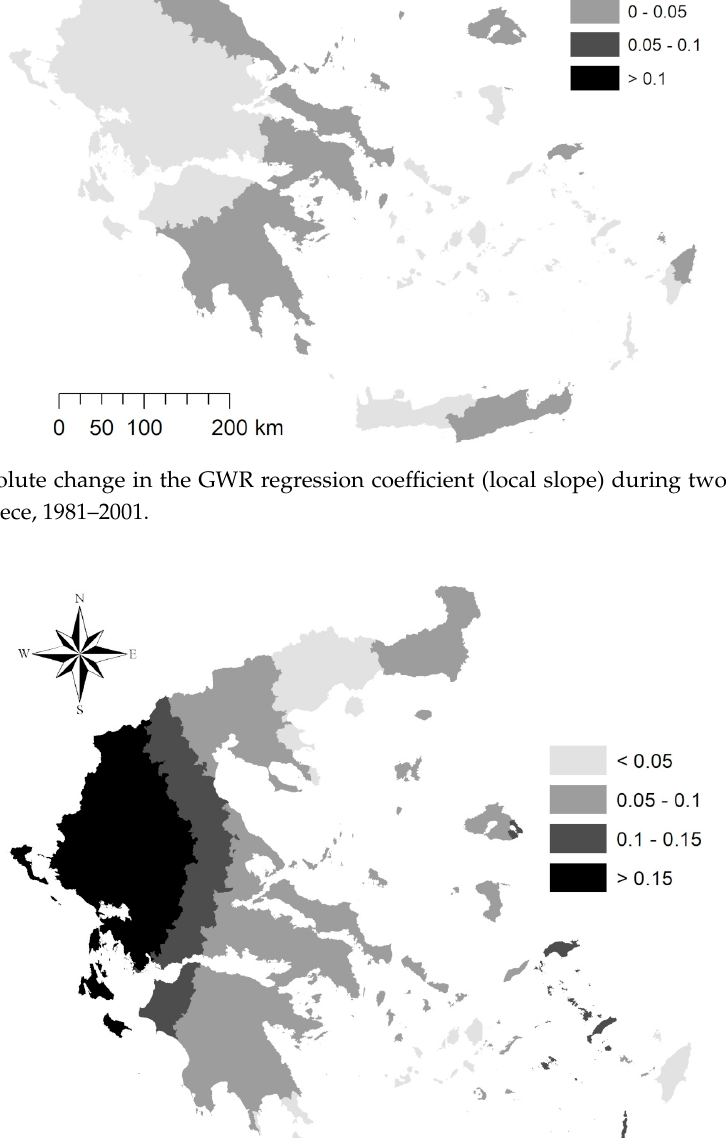
Figure 10. Absolute change in the GWR regression coefficient (local slope) during two consecutive decades in Greece, 1991–2011.